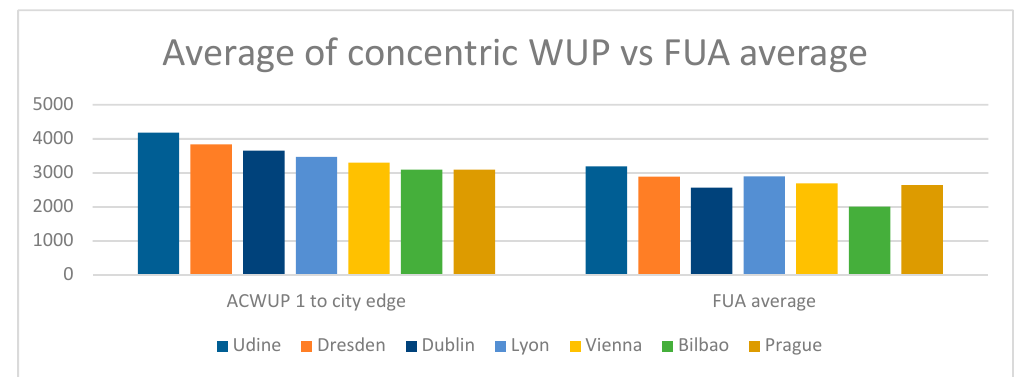
Figure 11. Comparison of the city ranking obtained using the Averaged Concentric Weighted Urban Proliferation (ACWUP) from a distance of 1 km to the city’s edge against the ranking obtained using the average per Functional Urban Area (FUA). Cities are listed in order of sprawl based on the European Environment Agency and European Commission’s Joint Research Centre’s 2006 report.